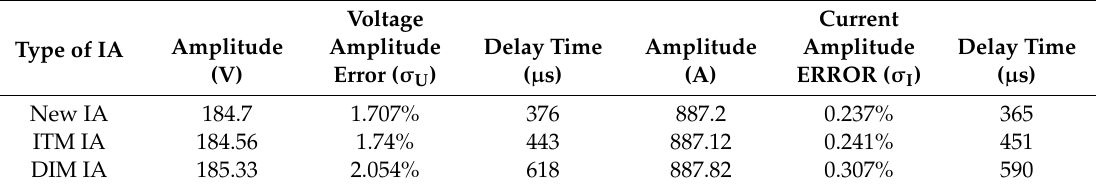
Table 5. Data analysis results of the DUT